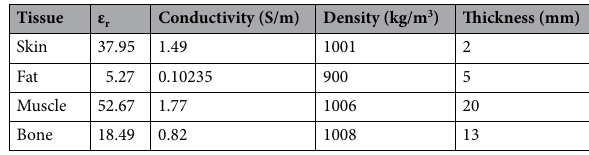
Table 5. The electromagnetic parameters of the human tissue.